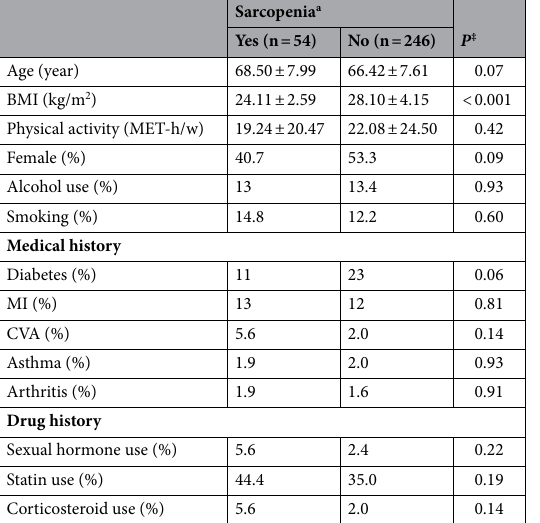
Table 1. General characteristics of people with and without sarcopenia. All values are mean ± SD, unless indicated. a Sarcopenia was defined based on European Working Group on Sarcopenia in Older People (EWGSOP) definition 27 . ‡ ANOVA for continuous variables and Chi-squared test for categorical variables. BMI body mass index, MI myocardial infarction, CVA cerebrovascular accident.